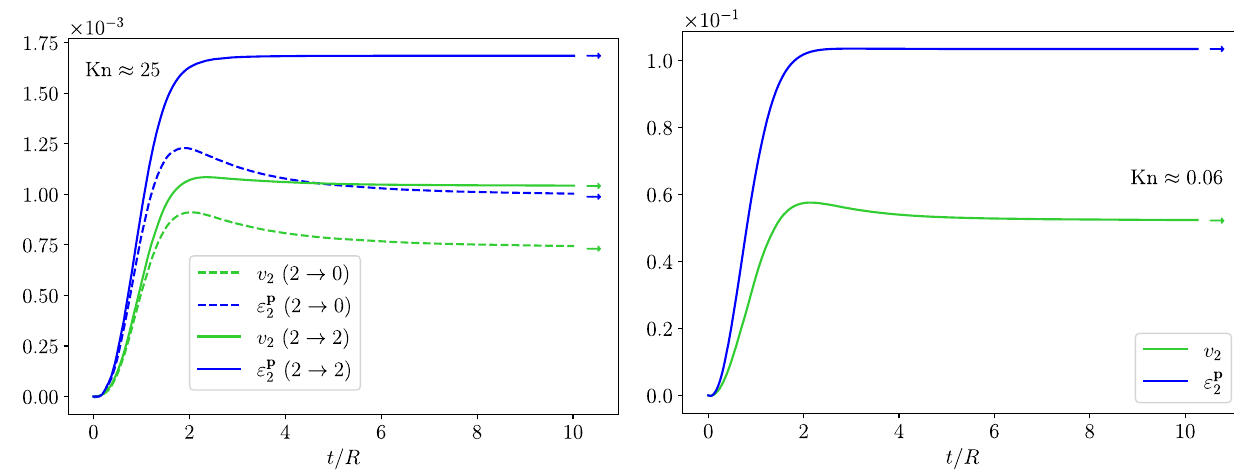
Fig. 17 Evolution of the anisotropic flow coefficient v 2 (green) and the eccentricity ε p in the few collisions limit (left) and in the hydrodynamic limit (right). The arrows indicate the corresponding values at t / R ≈